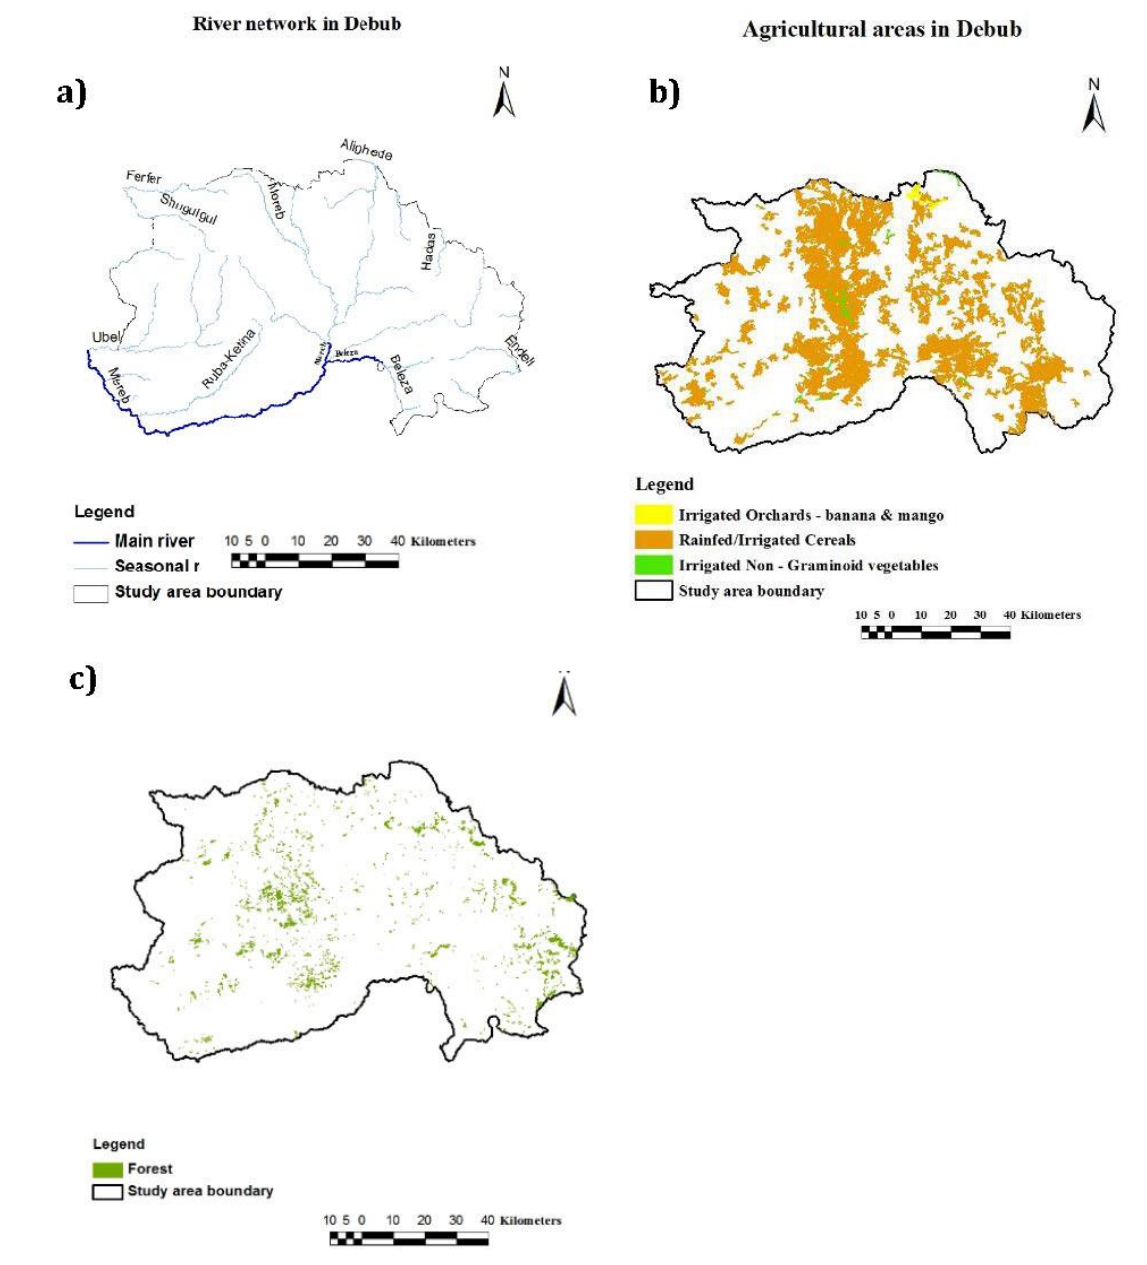
Figure 3. Constraint